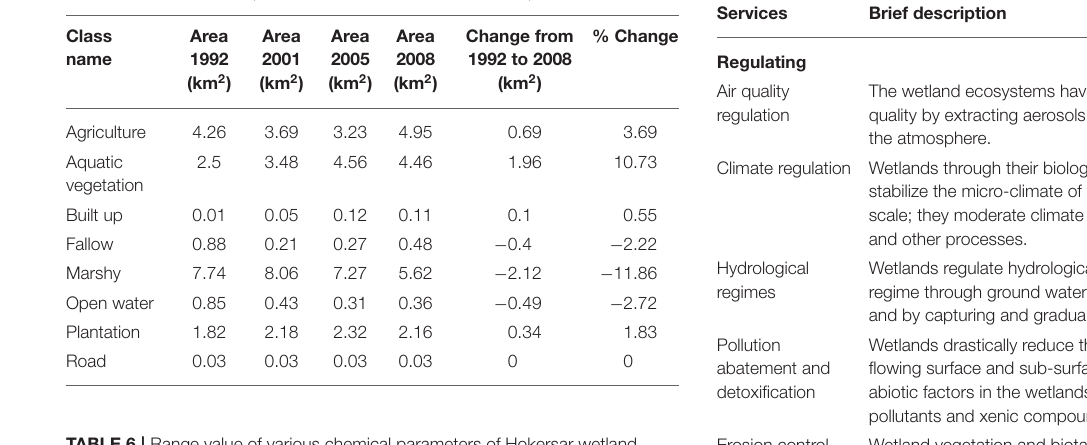
TABLE 6 | Range value of various chemical parameters of Hokersar wetland (Source: Kaul et al., 1978; Kaul and Trisal, 1985; Shah et al., 2019).